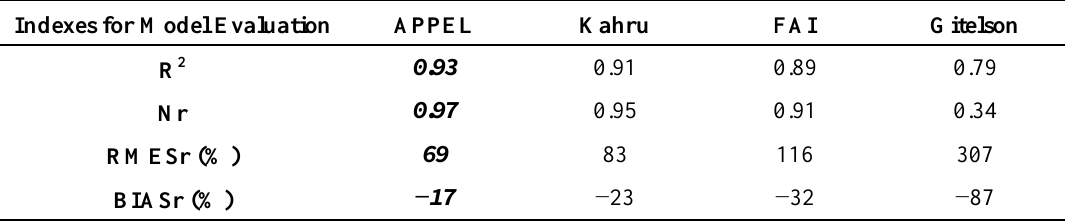
Table 2. Model performance using cross-validation results from the whole data